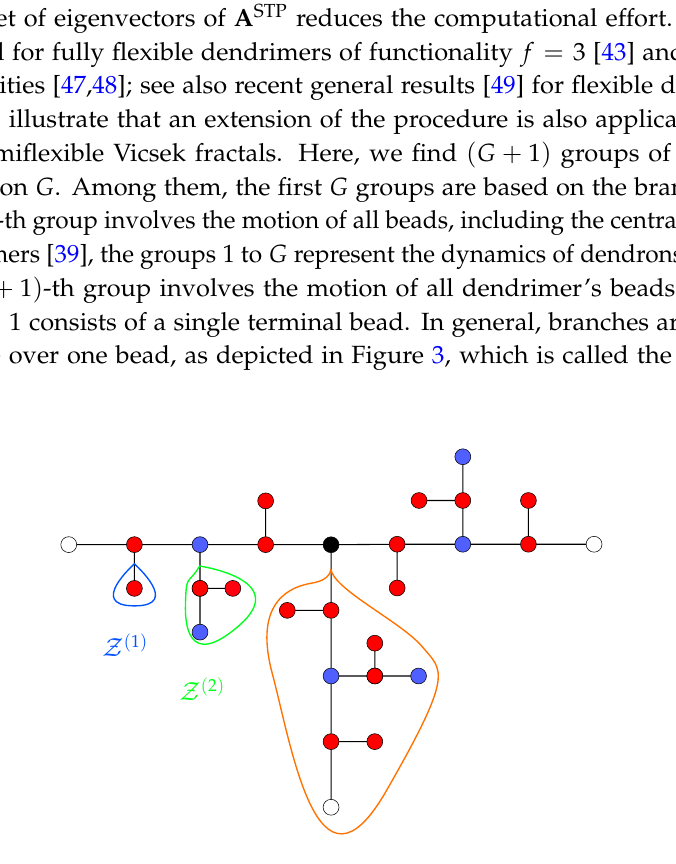
Z = 1,2,3 for a T-fractal of generation G = Z